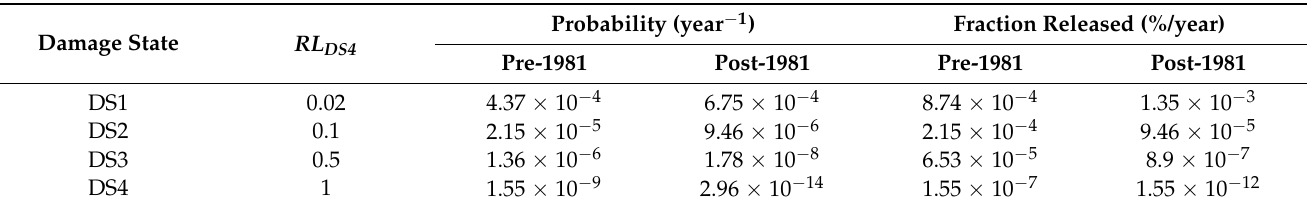
Table 3. Content fractions to be emi tt ed each year due to seismic risk for each damage state and Table 4. Content fractions to be emitted each year due to seismic risk for each damage state and other other CGEP framework parameters for L’Aquila. CGEP framework parameters for